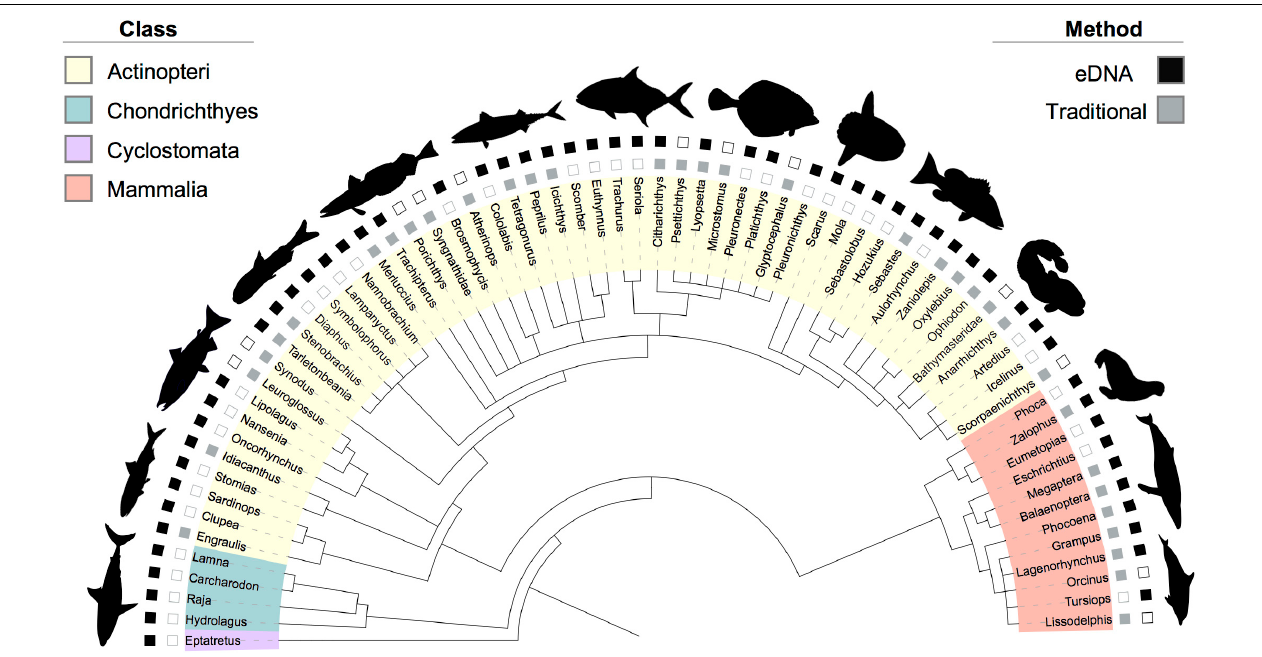
FIGURE 3 | Phylogenetic tree of the taxa diversity identified by eDNA, trawl, and marine mammal surveys across the two-year dataset. Taxa are annotated down to the most resolved level (genus). Classes are identified by leaf color. If a taxon was identified by eDNA, the corresponding outer square is solid (black); if identified by traditional methods (i.e., mid-water trawl or marine mammal visual surveys), the inner square is solid (gray). Empty squares denote no detection for that method. Bathymasteridae and Syngnathidae had no genera detected; therefore, the taxa family names are listed in the tree. Refer to Table 1 for further information on which method detected certain taxa in a given year or